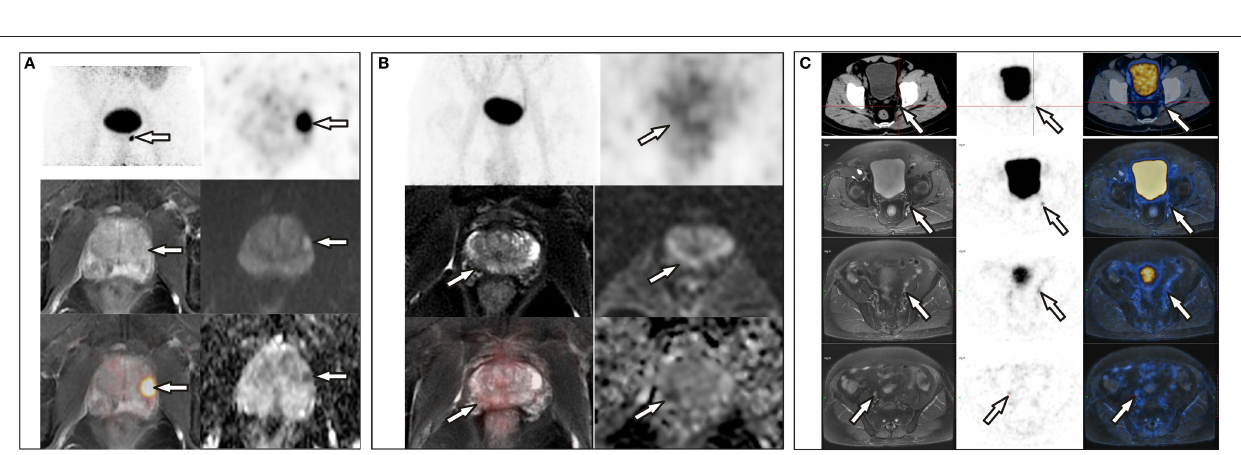
FIGURE 1 | (A) A 65-year-old man with a total PSA level of > 1,000 ng/L and free PSA > 30 ng/L underwent 68 Ga-PSMA PET/MR, which revealed extensive bone metastases but negative uptake of PSMA in the prostate. (B) A 64-year-old man with a total PSA level of 13.9 ng/L and free PSA of 2.15 ng/L underwent 68 Ga-PSMA PET/CT, which showed uptake in multiple lymph nodes in the left supraclavicular area, retroperitoneum, and the left iliac chain, but no focal uptake in prostate. Prostate acinar adenocarcinoma with left iliac lymph node metastases (6/6) were histopathologically proved.